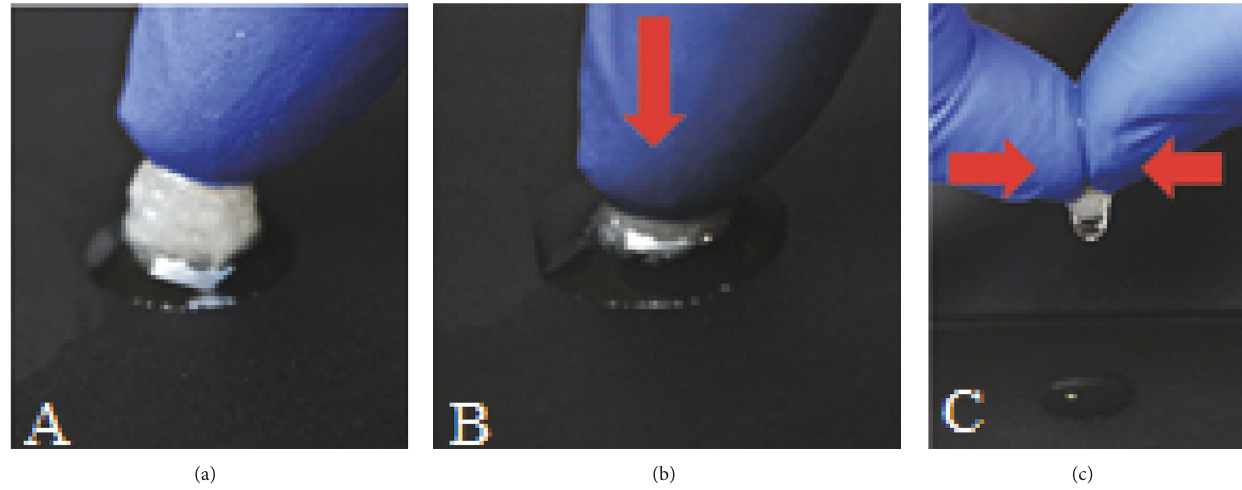
Figure 7: Water uptake ability and retention of the DSBCS group. (a) Shortly after being removed from the liquid bath, (b) when it was pressed, the liquid gushed out of the scaffold, (c) when squeezed pressed harder, the residual liquid still coming out from the scaffold.